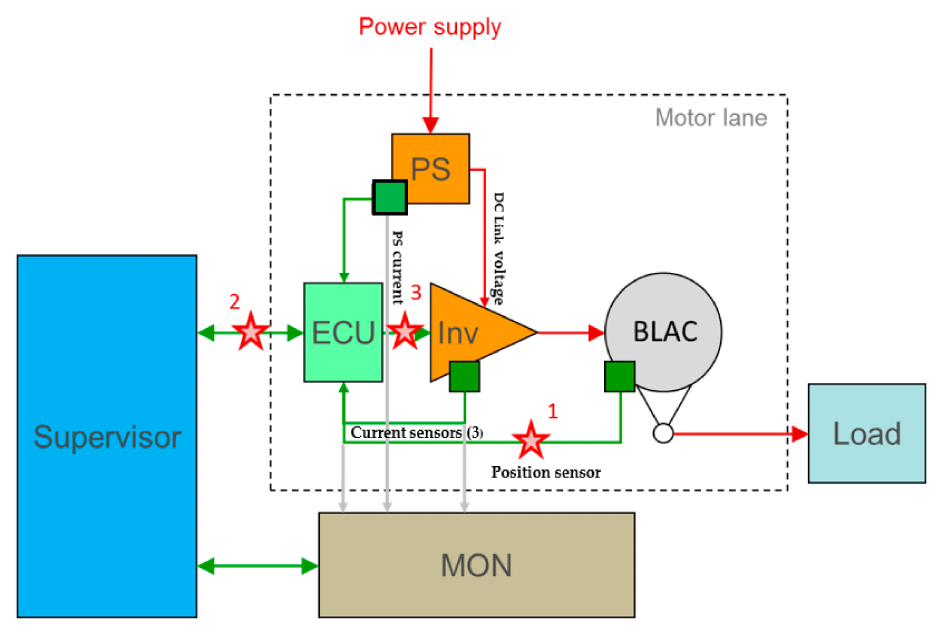
Figure 10. Faults of each BLAC motor in closed loop. 1: O ff set on position feedback information of one lane. 2: O ff set on position command information of one lane. 3: O ff set on the torque (or current) command of one lane.